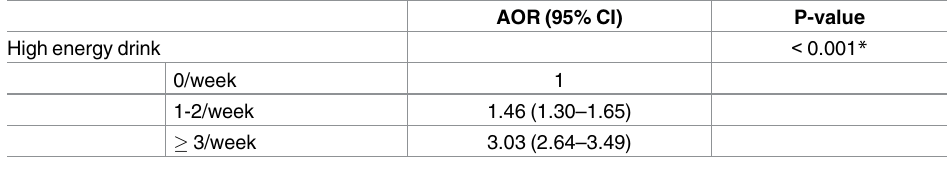
Table 4. Multiple logistic regression analyseswith complex sampling of energy drinks consumption for suicide